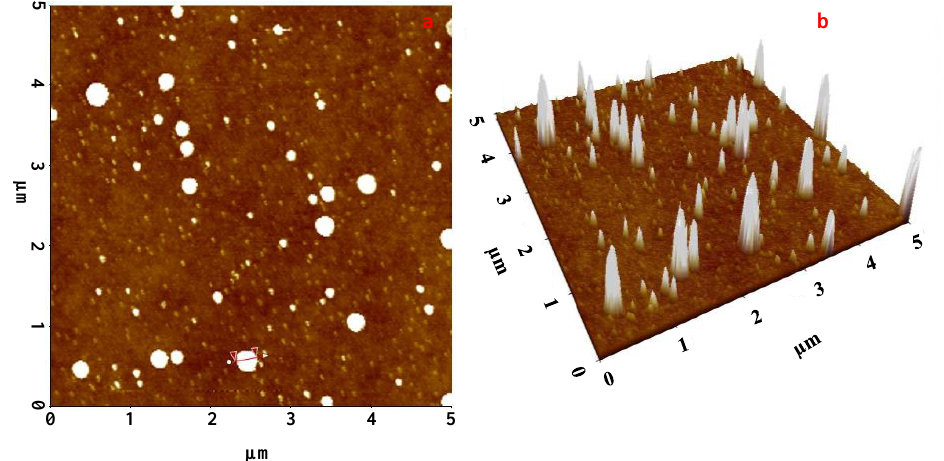
Figure 9. AFM analysis of ( a ) 2D image of SGP2 and ( b ) corresponding 3D images .